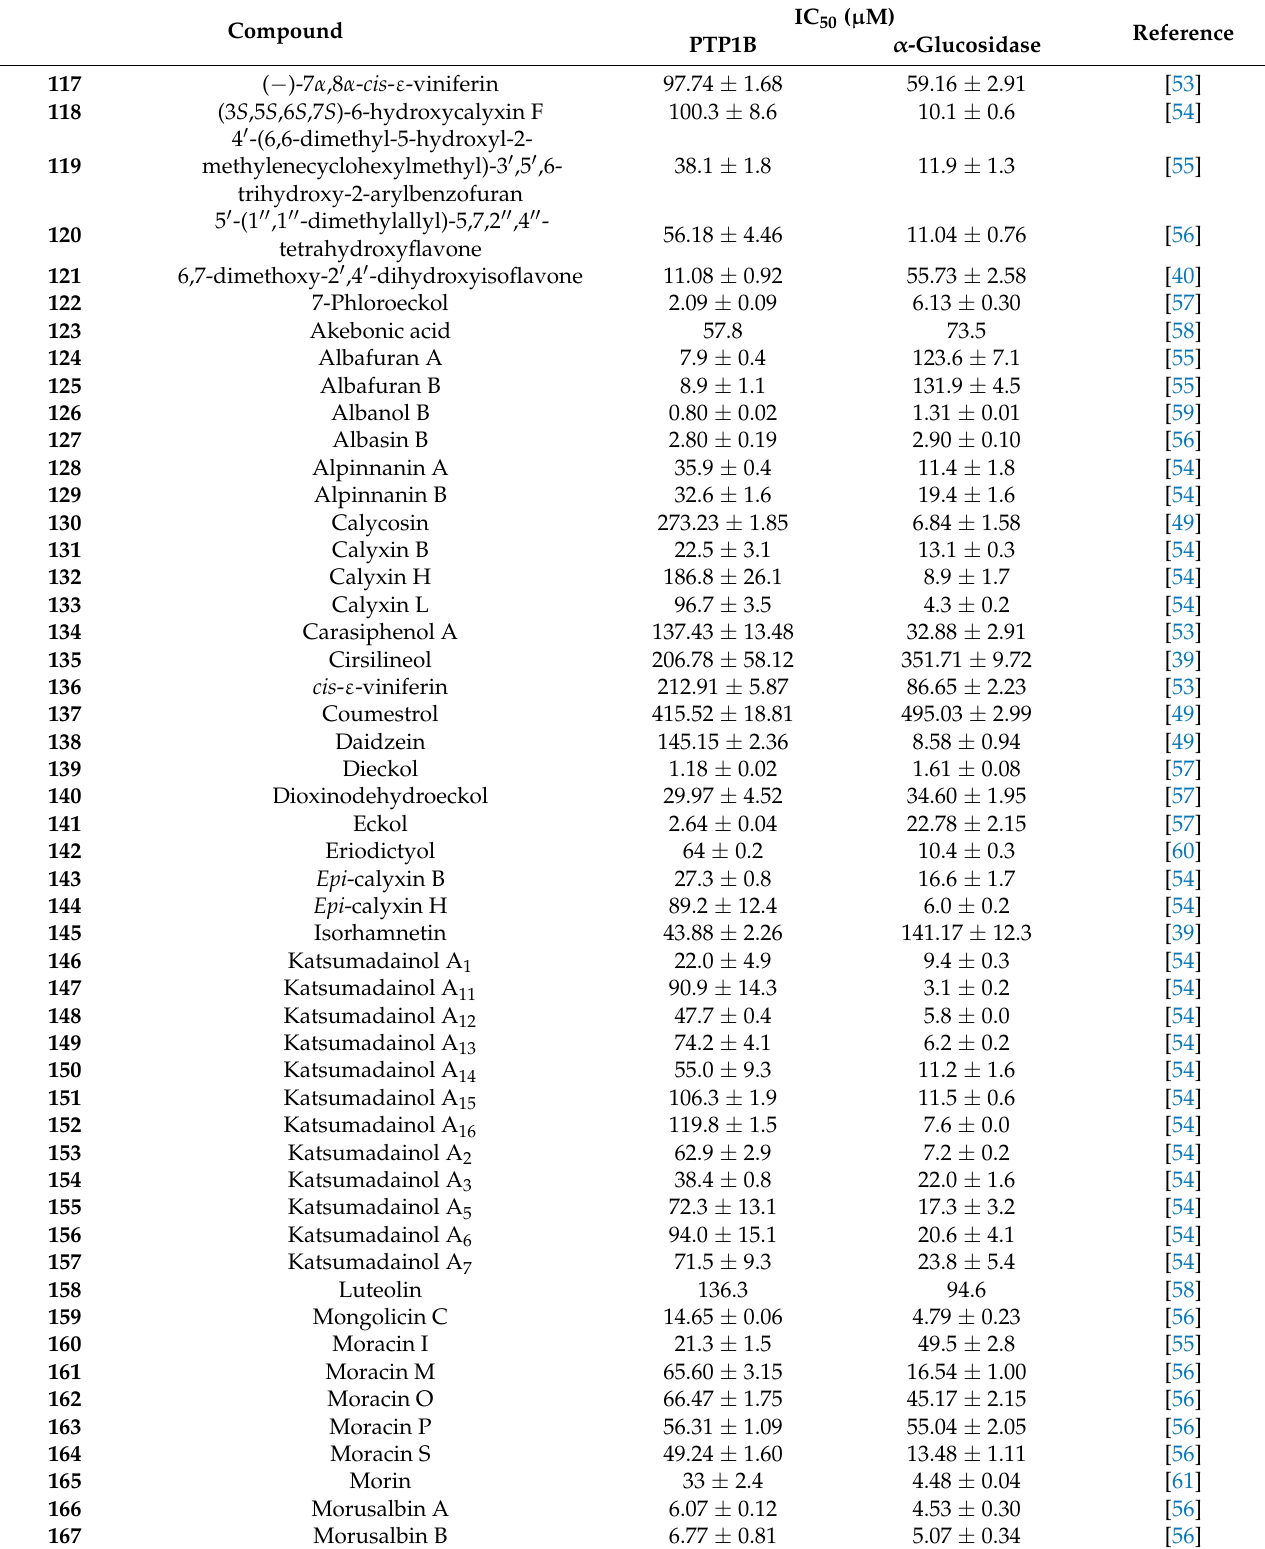
Table 8. Phenolic